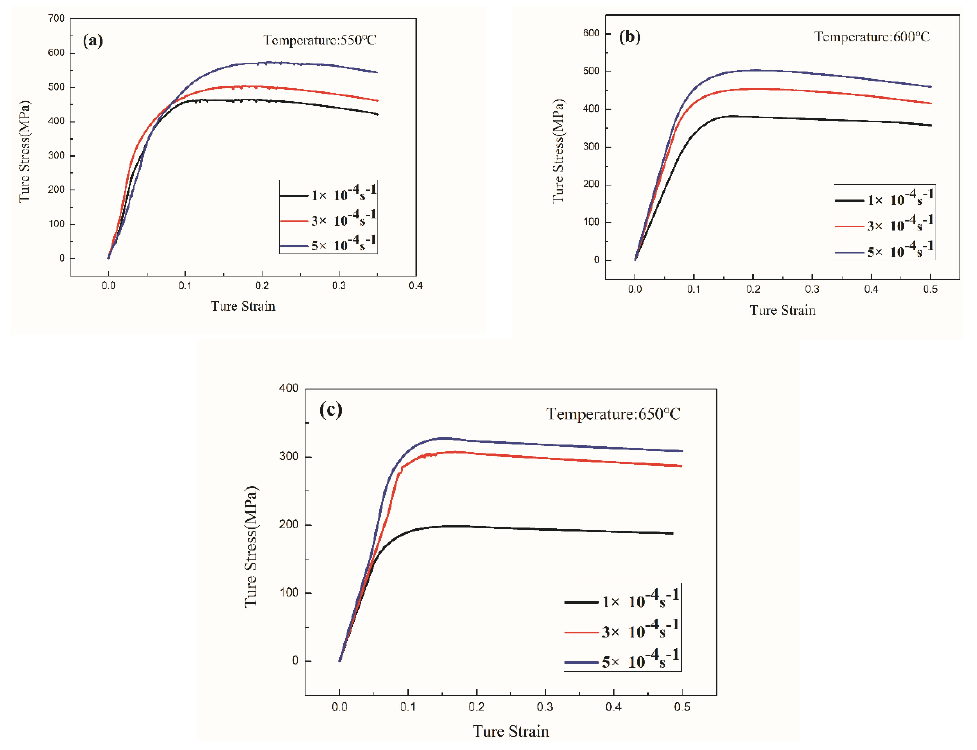
Figure 9. True stress-strain curves of Ti-7Al-0.2B at different temperatures and compressive rates.